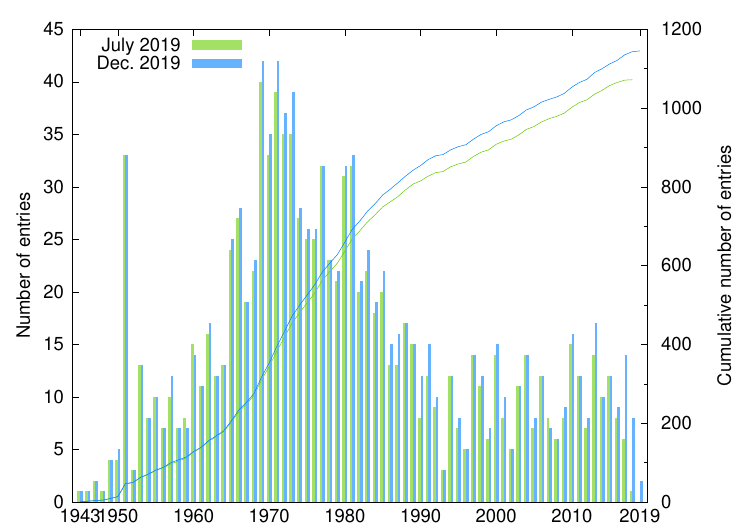
Figure 1. Number of FPY data entries in EXFOR based on the published